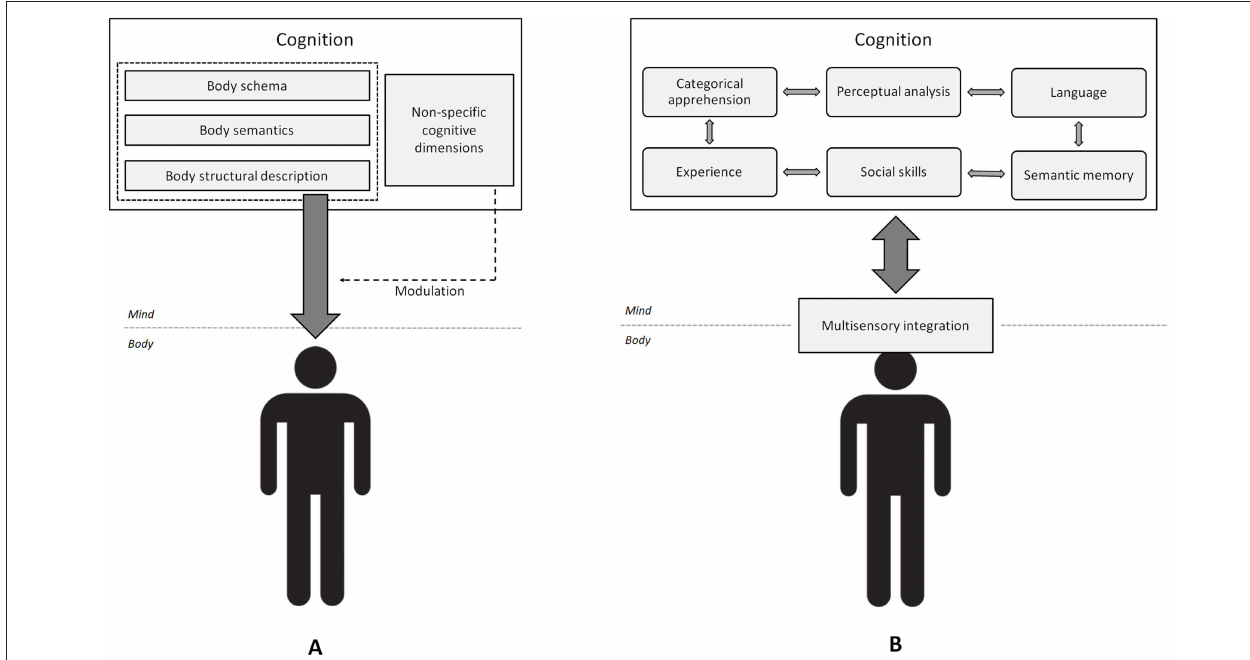
FIGURE 1 | Two epistemological accounts of bodily experience. (A) The cognitive account of bodily experience. Specific body representations determine bodily experience, while additional, non-specific cognitive components modulate the expression of these representations. (B) The structuralist account of bodily experience. There are no body-specific representations. Instead, all of the cognitive processes (not necessarily body-specific) interfere with multisensory integration, which results in bodily experience. Cognitive dimensions also interact with each other (small gray bidirectional arrows), resulting in various phenomena. Adopted from https://